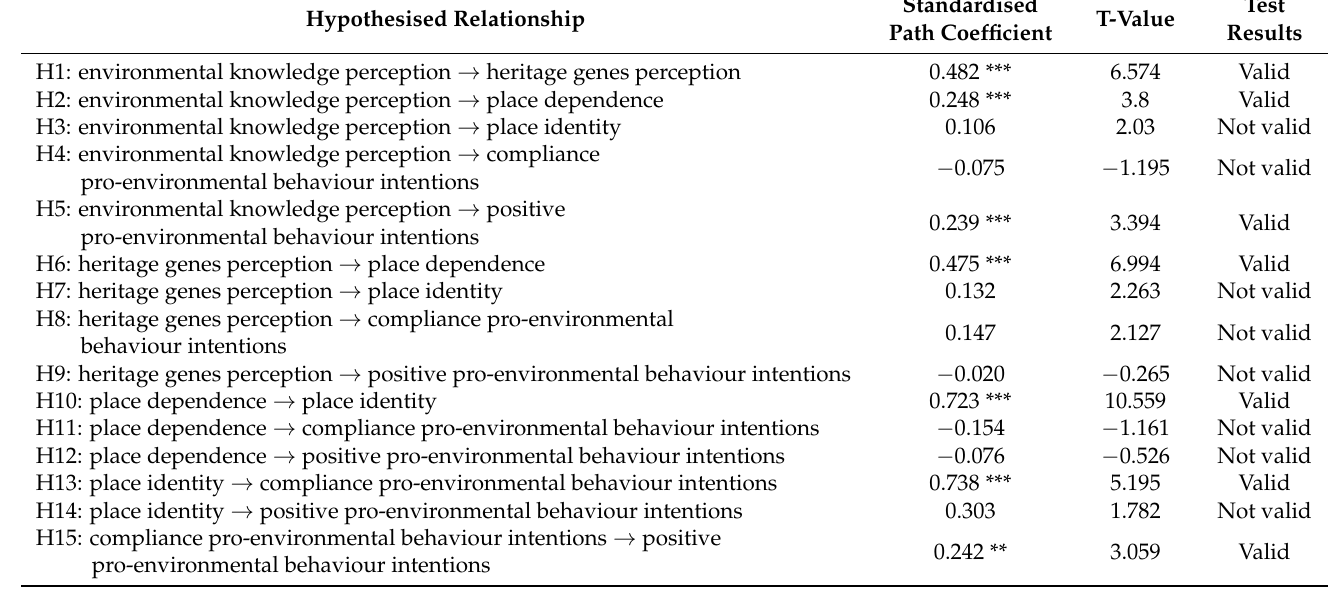
Standardised Test T-Value Path Coefficient